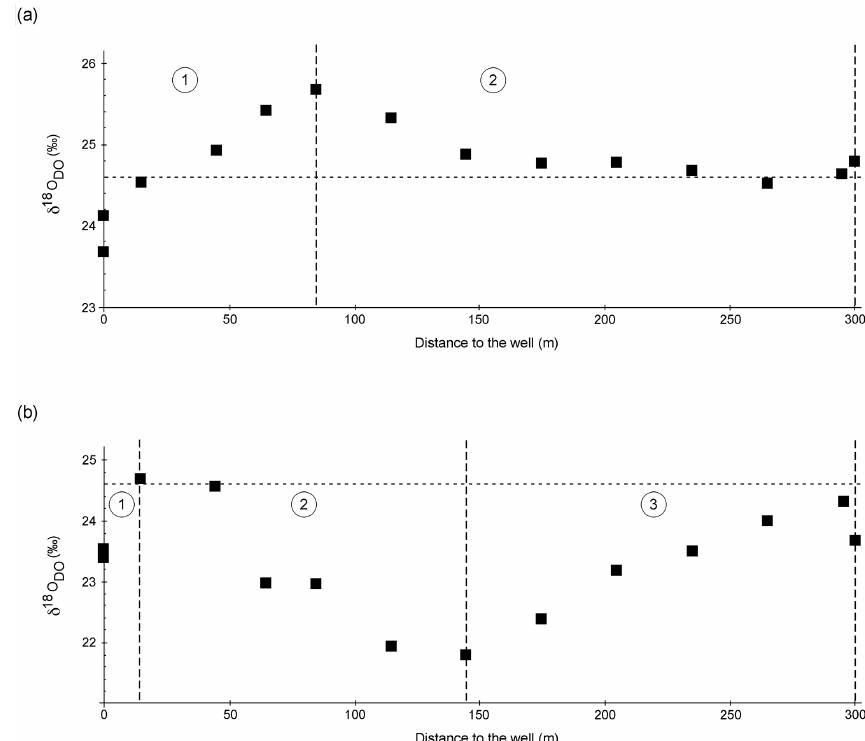
Figure 5. δ 18 O DO in the cold season (a) and the warm season (b) over the course of the Espan Spring and stream system with the atmospheric equilibrium value of + 24.6‰ marked by the horizontal dashed lines. Dashed vertical lines show borders of the different zones of the fields labelled with 1, 2 and 3. The symbol size is larger than the error